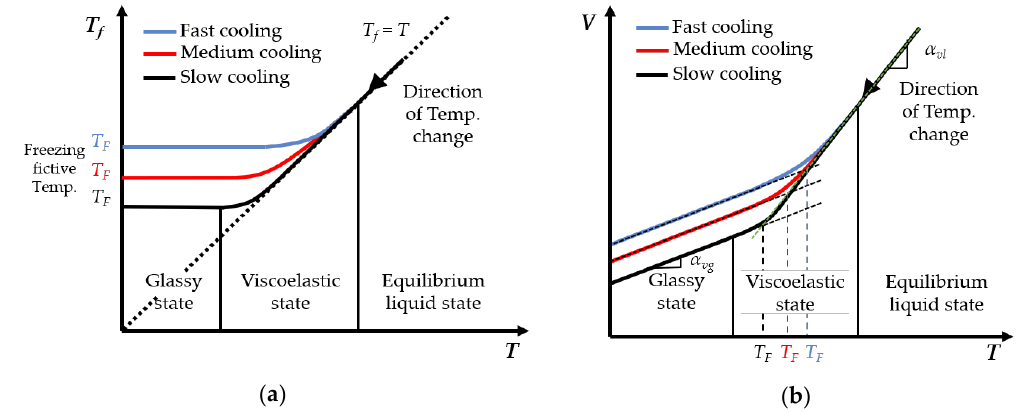
Figure 3. Schematic diagram of fictive temperature and volume change of the glass during the cooling stage in the PGM process. ( a ) Fictive temperature vs. actual temperature. ( b ) Volume change of glass vs. actual temperature.